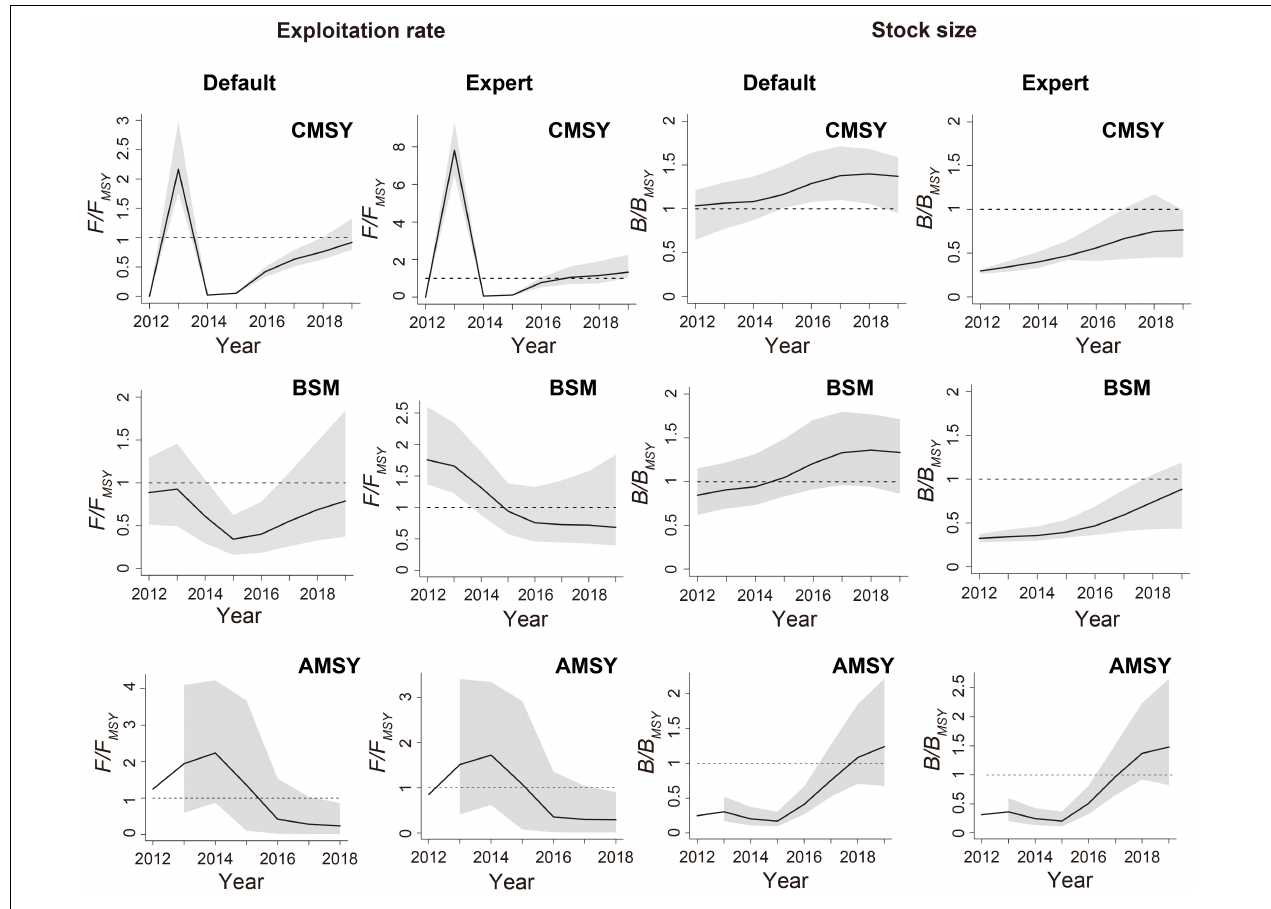
FIGURE 4 | Estimated relative biomass ( B/B MSY ) and fishing mortality ( F/F MSY ) trajectories for the Yellow Sea stock, with the gray areas indicating the